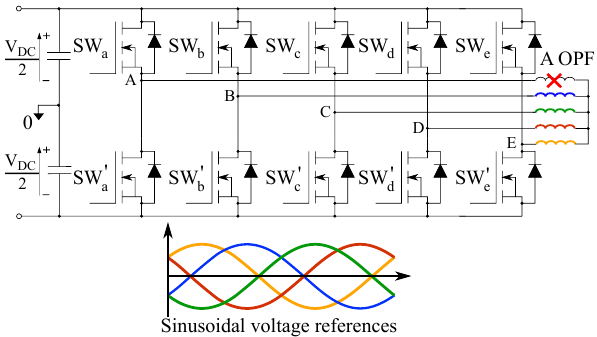
Figure 1. Five-phase inverter under an OPF on phase a